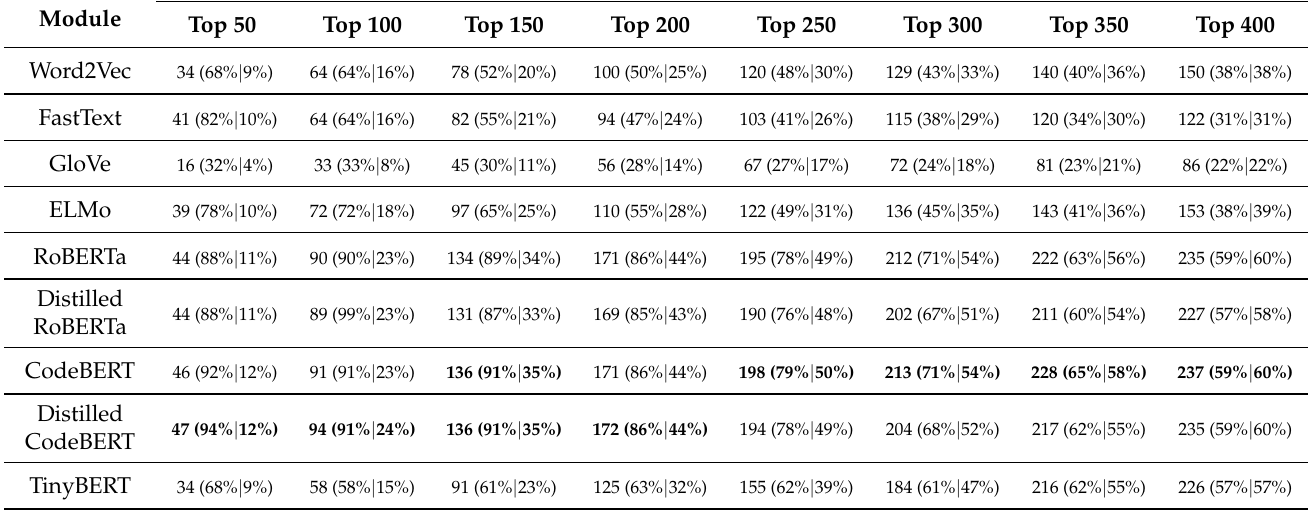
Table 6. The comparison results of using nine different embedding solutions for function-level vulnerability detection. The nine models are three NCMs which are Word2Vec, FastText, and GloVe; three PCMs which are ELMo, RoBERTa, and CodeBERT; three distilled PCMs which are distilled RoBERTa, distilled RoBERTa, and distilled